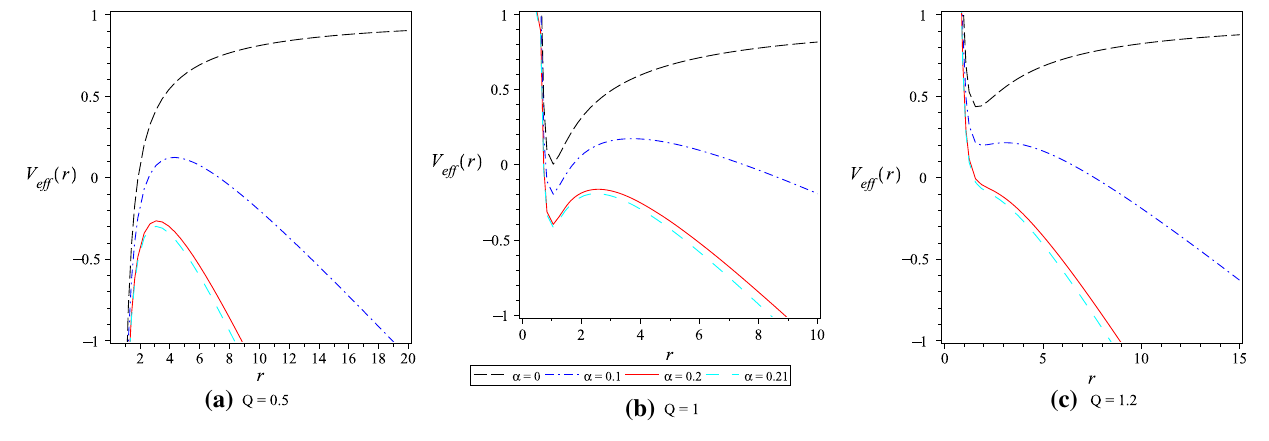
Fig. 1 The effective potential for M = L = 1 and ε = − 2 / 3